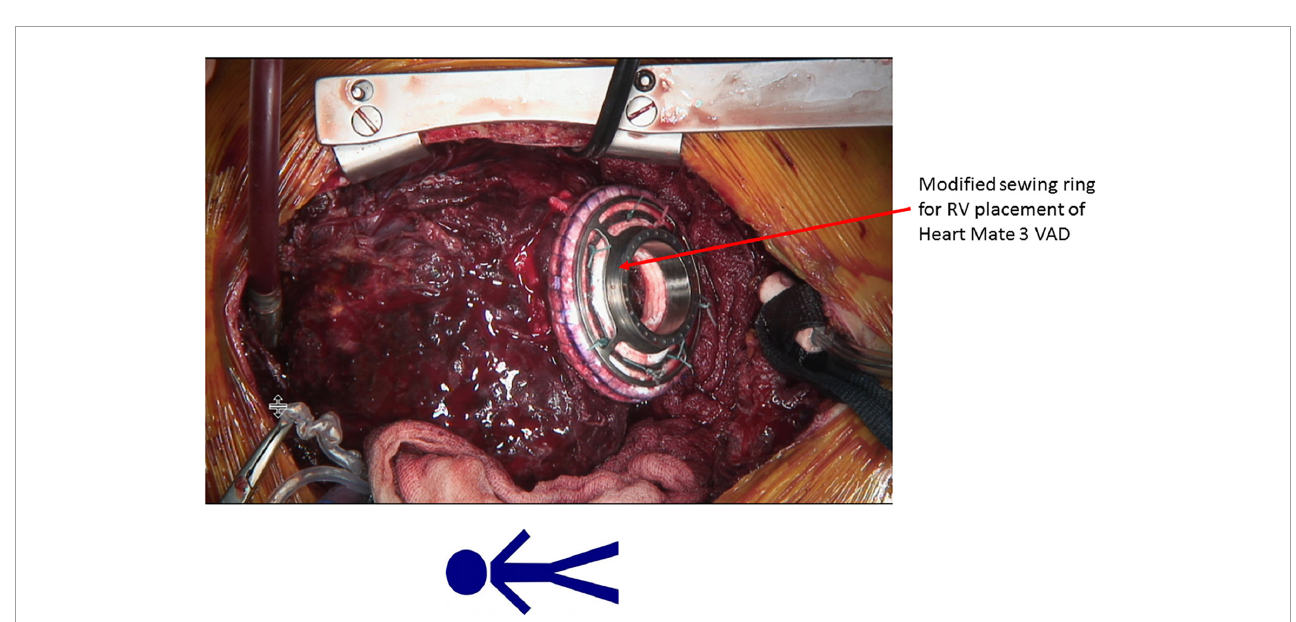
FIGURE2 Modified sewing ring with four layers of felt pledget plates for right ventricular positioning of the Heart Mate 3.